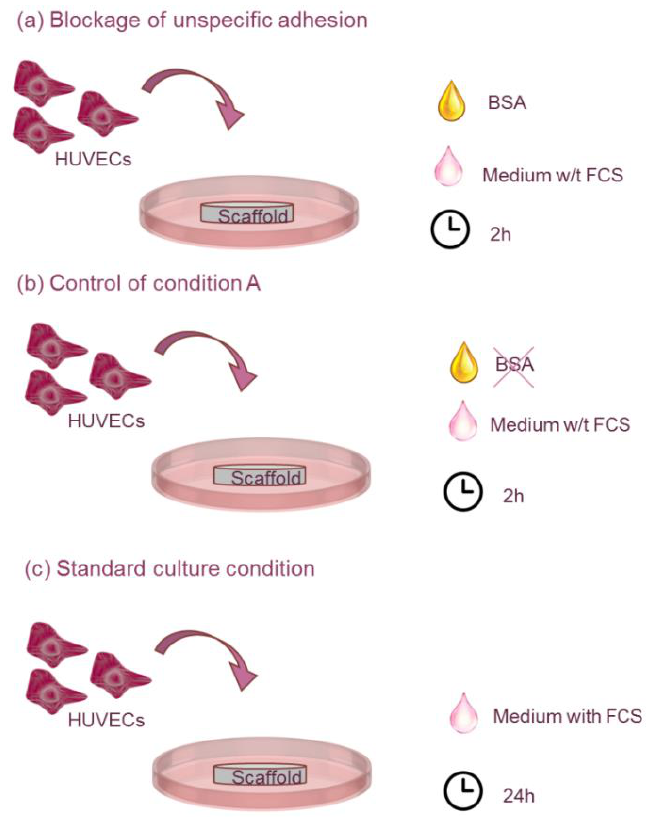
Figure 1. Schematic representation of the experimental groups assessed for adhesion of human umbilical vein endothelia cells (HUVECs) to the composite scaffolds. ( a ) HUVECs suspended in media without FCS and seeded on BSA-treated scaffolds. ( b ) HUVECs suspended in media without FCS and seeded on scaffolds (non BSA-treated). ( c ) HUVECs suspended in media with FCS and seeded on scaffolds without BSA pre-treatment.